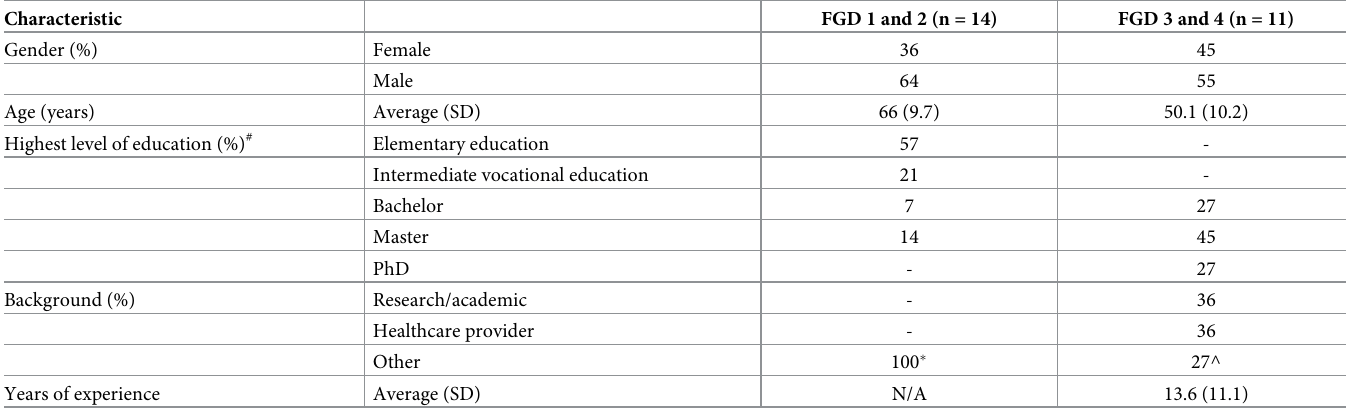
Table 1. Characteristics of